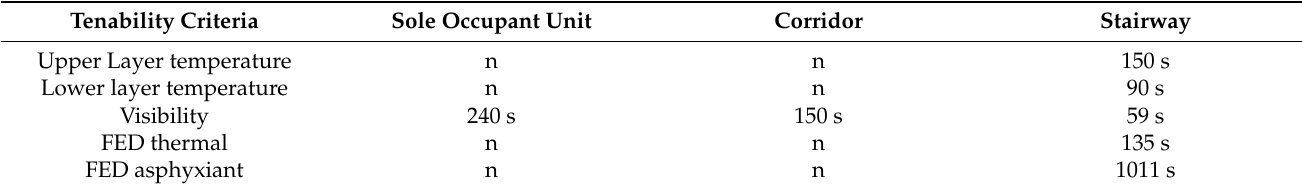
Table 4. Results from B-Risk simulation for case #1 Blocked Exit